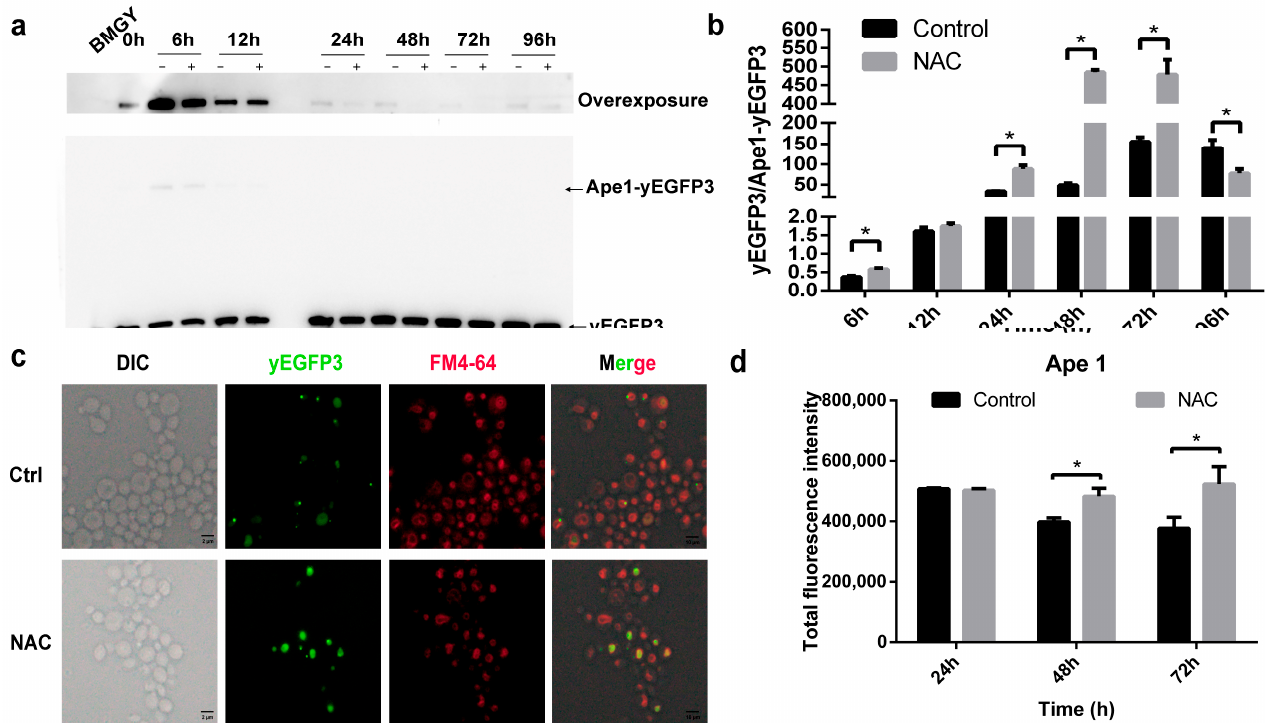
Figure 5. Effect of NAC on the Cvt pathway in FApe1 strain. ( a ) Western blot analysis of GFP in FApe1 strain that overexpressed Ape1-yEGFP3 in F strain. ( b ) The relative amounts of protein bands in Figure 5a were estimated using Image J analysis software. The results presented in the histogram reflect the fold-change in yEGFP3 and Ape1-yEGFP3. p values were calculated using Student’s two-tailed t -test with p < 0.05 considered statistically significant (Marked with *). Error bars represent means ± standard deviation (SD) (n = 3). ( c ) yEGFP3 and yEGFP3 fused proteins were observed using a fluorescence microscope in FApe1 strain after 72 h of NAC treatment. ( d ) Total fluorescence intensity of FApe1 strain treated with NAC for different times was measured by using SpectraMax i3 fluorescence microplate reader with an excitation wavelength at 485 nm, and emission wavelength at 535 nm. p values were calculated using Student’s two-tailed t -test with p < 0.05 considered statistically significant (Marked with *). Error bars represent means ± standard deviation (SD) (n = 3).